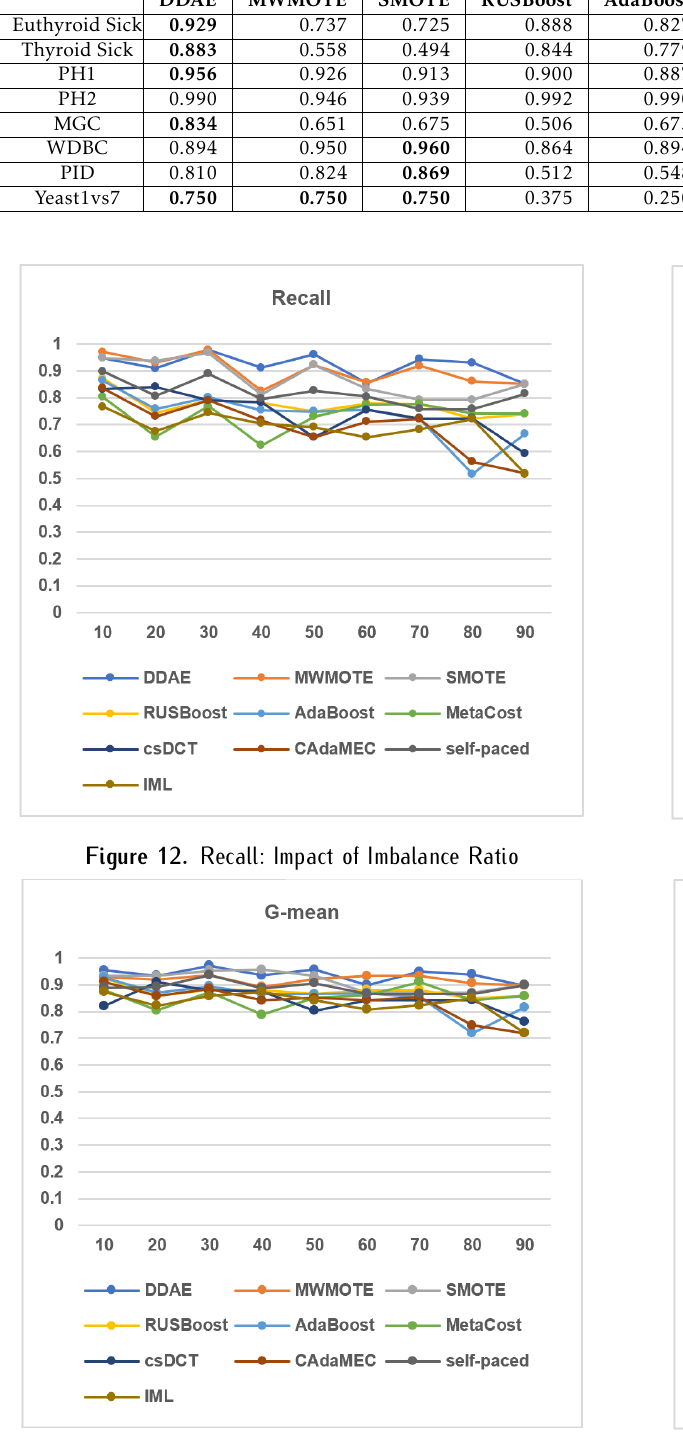
with only a slight decrease/increase, the changes